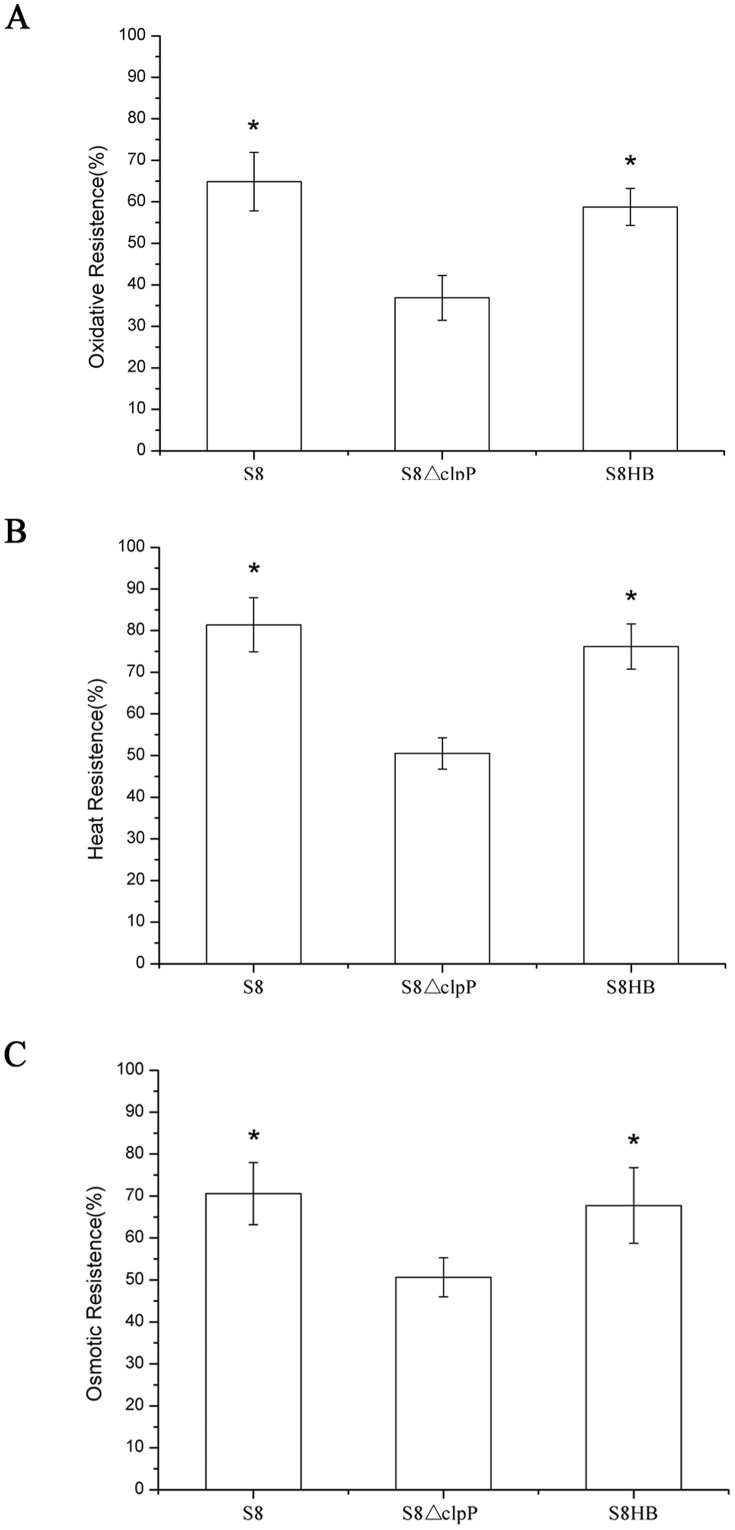
Impaired stress tolerance of the A. pleuropneumoniae S8ΔclpP mutant.Overnight cultures were inoculated into fresh medium and grown to an OD600 value of approximately 0.6. Cells were then treated with (A) 1 mM H2O2 for 30 min, * p<0.01, (B) 52°C heat shock for 20 min, *p<0.01, or (C) 0.3 M KCl for 1 hour, * p<0.05. * denotes P values (t test) for comparison to S8ΔclpP.